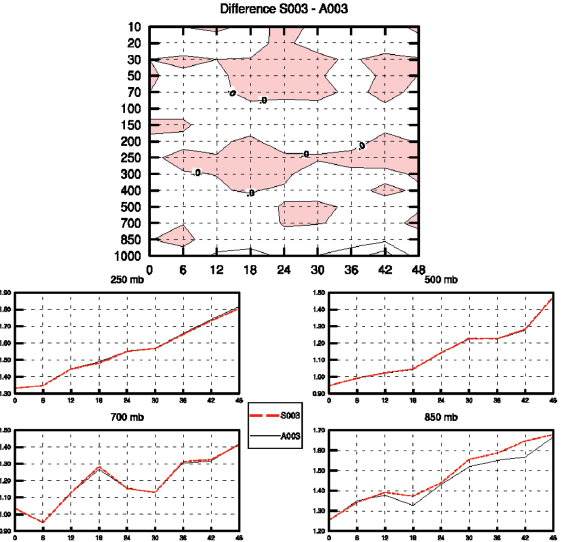
Fig. 16. Top: vertical profile of the temperature rmse difference be- tween a run with (S003) and without SURFEX (A003) as a func- tion of forecast range averaged over a winter period (10 Decem- ber 2010–29 December 2010) and over the whole domain. Red shaded areas mean that the use of SURFEX improve the scores. Bottom: temperature rmse of the run with (red line) and without (black line) SURFEX at different pressure levels (250, 500, 700 and 850mb).